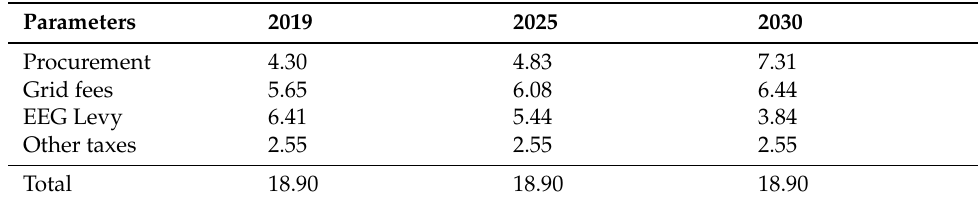
Table A1. Electricity prices by components.